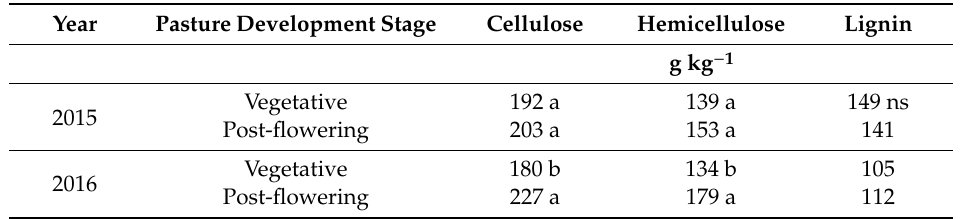
Table 2. Composition of dung sampled at di ff erent pasture development stages in 2015 and 2016 winter stocking periods of a no-till integrated soybean-sheep production system. Results are the averages of low and moderate grazing